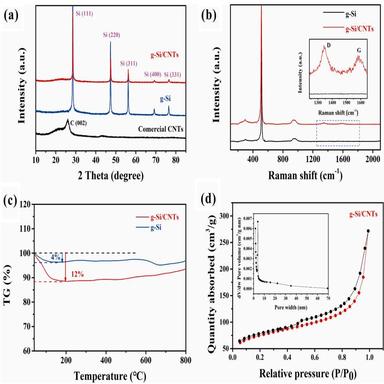
(a) XRD patterns of CNTs, g-Si and g-Si/CNT composite; (b) Raman scattering spectra of g-Si and g-Si/CNT composite; (C) TGA curves of g-Si and g-Si/CNT composite; (d) Nitrogen adsorption/desorption isotherms and (inset) pore diameter diagram of g-Si and g-Si/CNT composite.